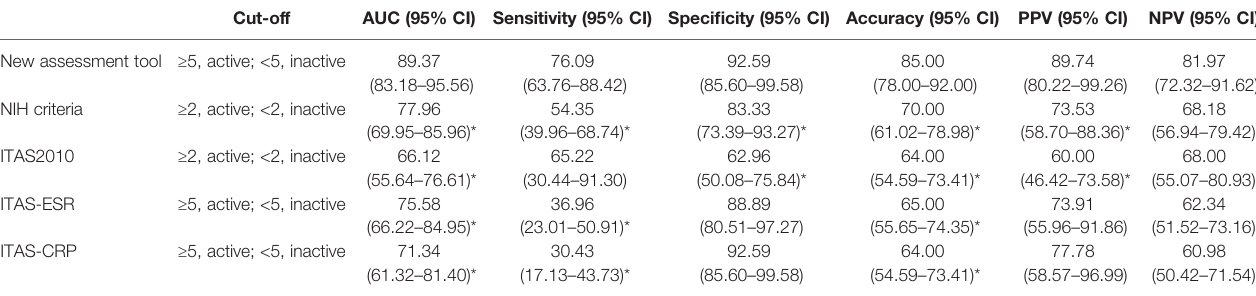
TABLE 5 | Diagnostic performance of disease activity assessment tools in the derivation cohort. Cut-off